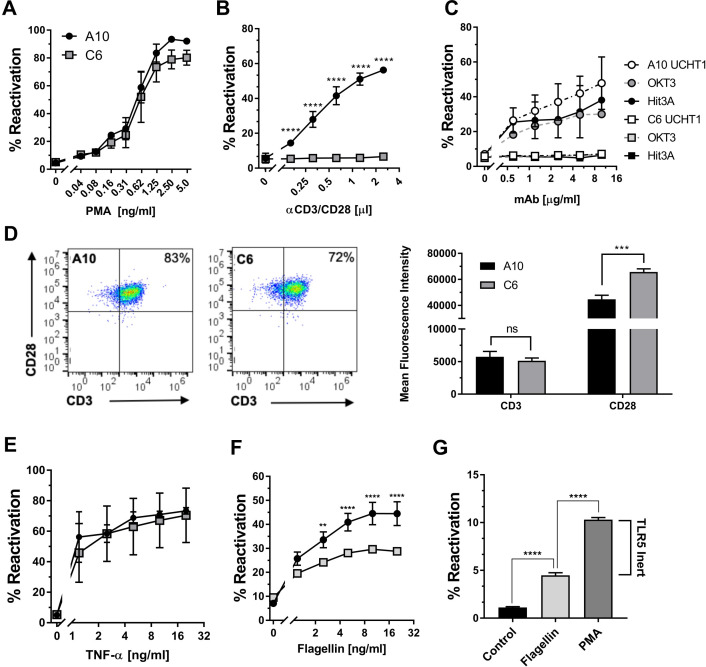
Generation of TCR/CD3-inert and -responsive latently HIV-1 infected T cell clones.(A) HIV-1 reactivation levels in JWEAU-A10 and JWEAU-C6 T cells following stimulation with increasing concentrations of the PKC/NF-κB activating phorbolester PMA as determined by flow cytometric analysis for GFP expression. (B) HIV-1 reactivation levels in JWEAU-A10 and JWEAU-C6 T cells following stimulation with increasing concentrations of α-CD3/CD28 mAb as determined by flow cytometric analysis for GFP expression. (C) HIV-1 reactivation levels in JWEAU-A10 and JWEAU-C6 T cells following stimulation with increasing concentrations of different α-CD3 mAbs (OKT3, UCHT1, HIT3A) as determined by flow cytometric analysis for GFP expression. (D) Expression levels of CD3 and CD28 proteins on JWEAU-A10 and JWEAU-C6 T cells as determined by flow cytometric analysis. (E) HIV-1 reactivation levels in JWEAU-A10 and JWEAU-C6 T cells following stimulation with increasing concentrations of TNF-α. (F) HIV-1 reactivation levels in JWEAU-A10 and JWEAU-C6 T cells following stimulation with increasing concentrations of the TLR5 agonist flagellin. (G) HIV-1 reactivation levels in a long-term HIV-1 infected T cell population holding a 10% latently infected subpopulation following stimulation with optimal concentrations of the TLR5 agonist flagellin or PMA. Where indicated, data represent the mean ± standard deviation of at least three independent experiments.